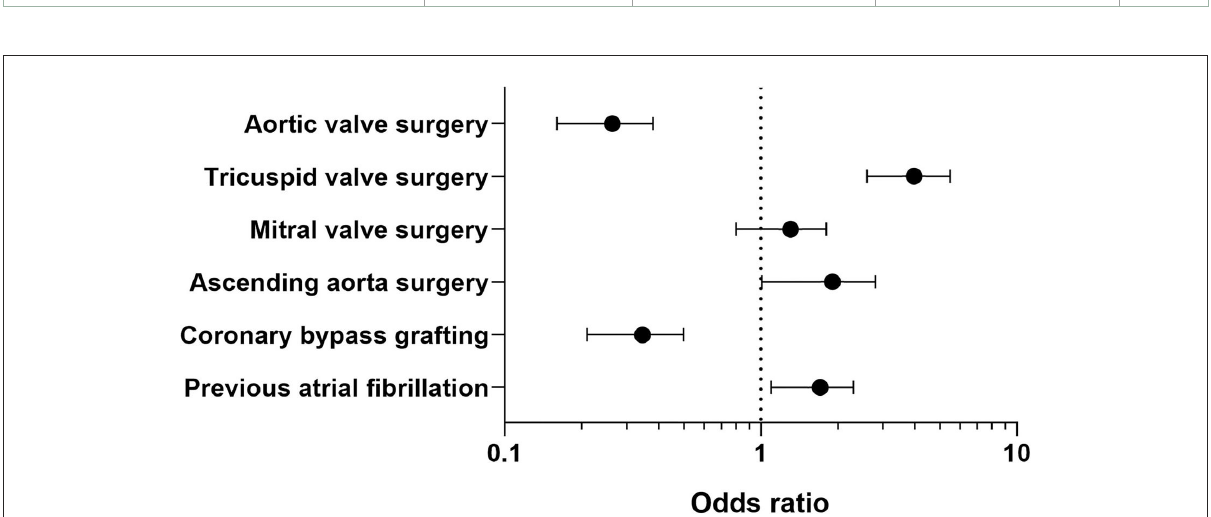
FIGURE1 Predictors of PFO finding in multivariate